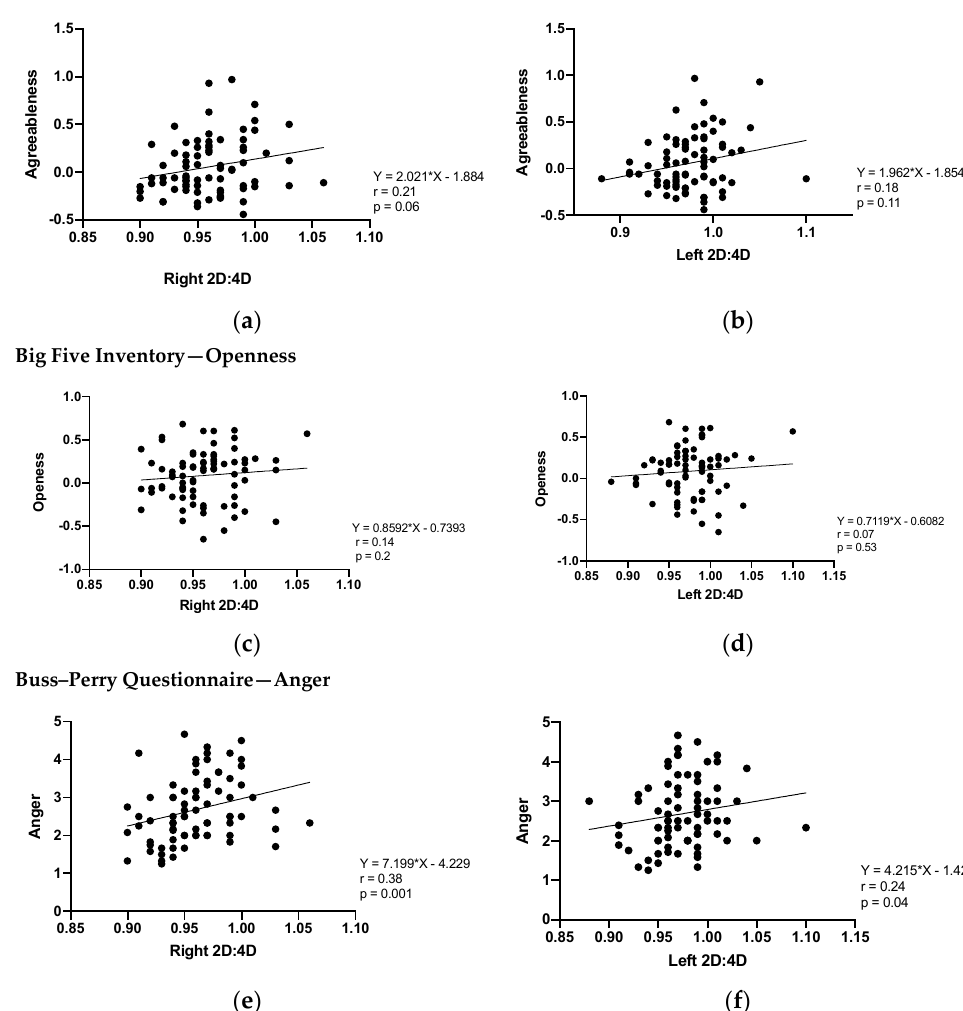
Figure 5. Spearman’s correlation between right 2D:4D and BFI agreeableness ( a , b ); BFI openness ( c , d ) and BPQ anger ( e , f ) in professional MMA athletes + non-athletes (n = 77). Significant differences ( p > 0.05) only in BPQ anger for 2D:4D in both hands.